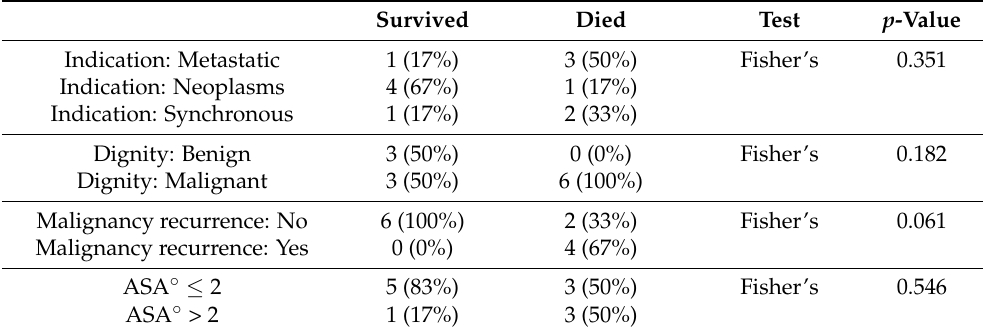
Table 3. Frequency counts and means ± SE for MPP patients known to survive for 10 years (N = 6) and those who died within 10 years (N =